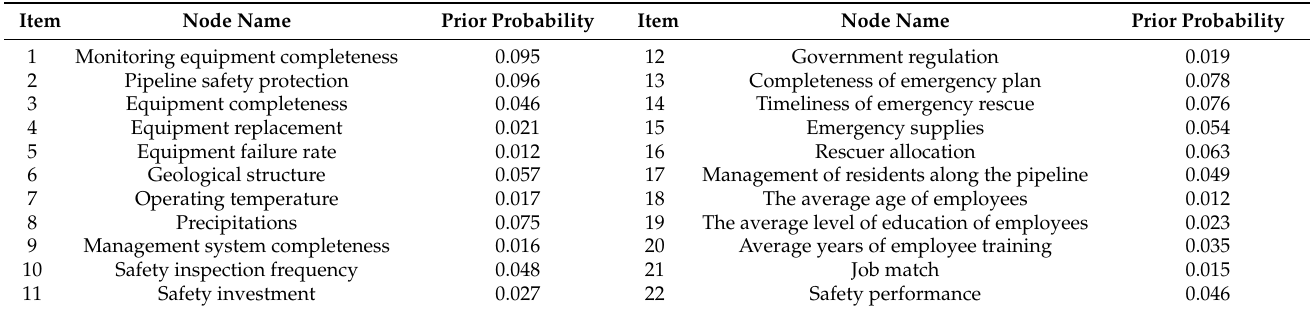
Table 5. The prior probability of pipeline third-party damage relevant